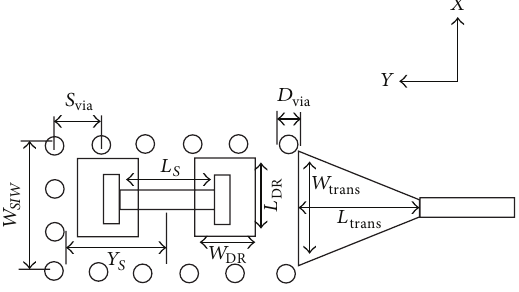
Figure 2: SIW antenna design parameters (top